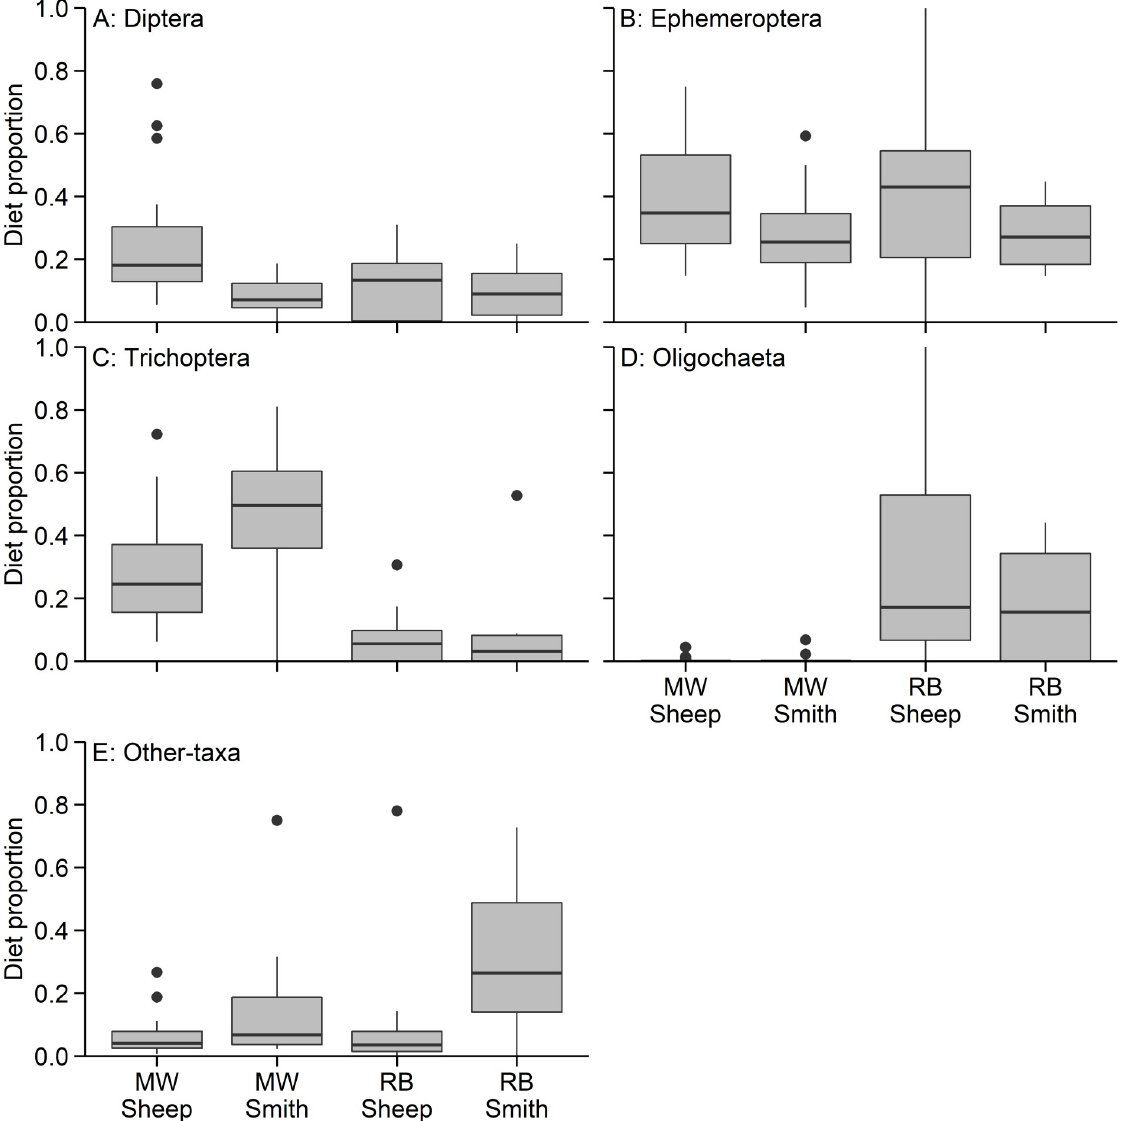
Fig 2. Diet categories grouped by order. Standard boxplots showing proportions of diet item from the specified category found in mountain whitefish (MW) and rainbow trout (RB) in Sheep Creek and the Smith River. Panels show proportions of (A) Diptera; (B) Ephemeroptera; (C) Trichoptera; (D) Oligochaeta; and (E) any other taxa pooled. Box ends represent the 25 th and 75 th quantiles, horizontal lines are the medians, the upper whisker extends to the largest observation no further than 1.5 × interquartile range (IQR) from the 75 th quantile, and the lower whisker extends to the smallest observation no further than 1.5 × IQR from the 25 th quantile.